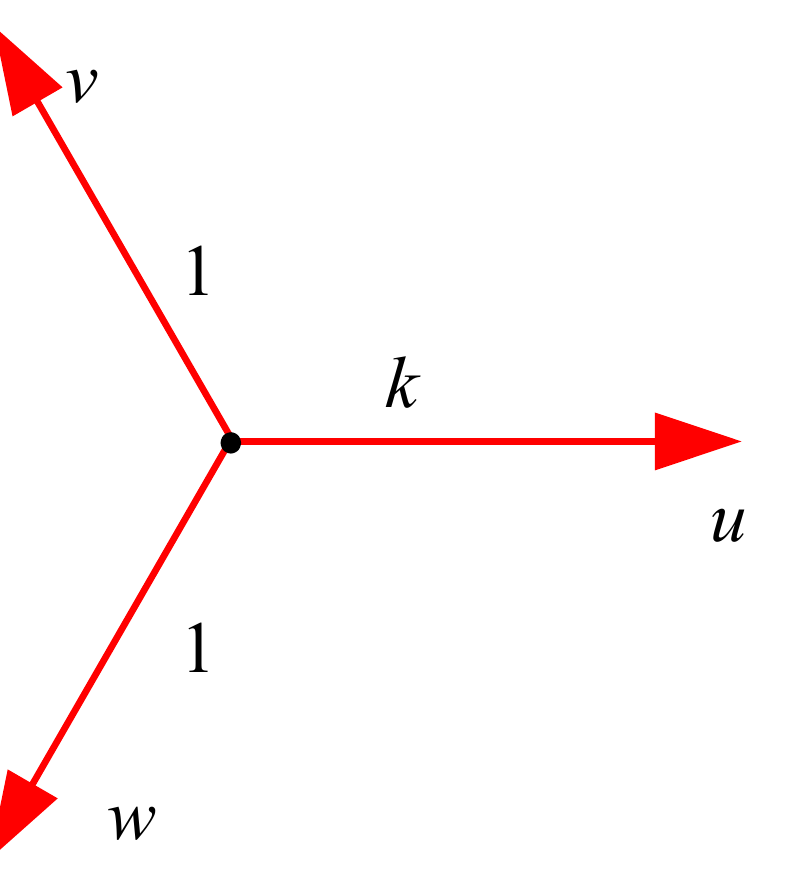
Figure 4. Standardized reference coordinate system with phase u broken.